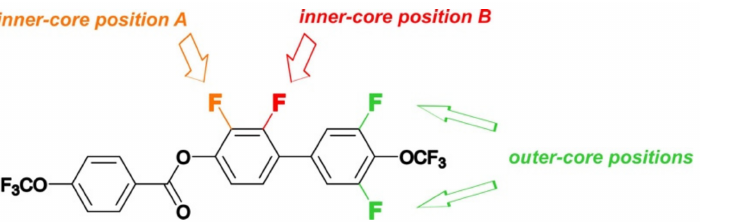
Figure 10. Positions of fluorine substituents in 4 (cid:48) -(trifluoromethoxy)-[1,1 (cid:48) -biphenyl]-4-yl-4- (trifluoromethoxy) benzoates (group 1 compounds): inner core position A (orange), inner core position B (red), and outer core position (green).